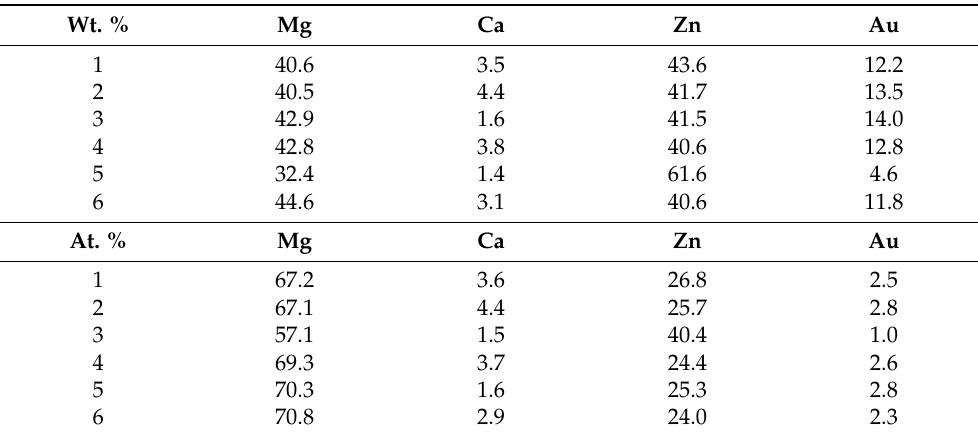
Table 3. EDS results from the areas marked in Figure